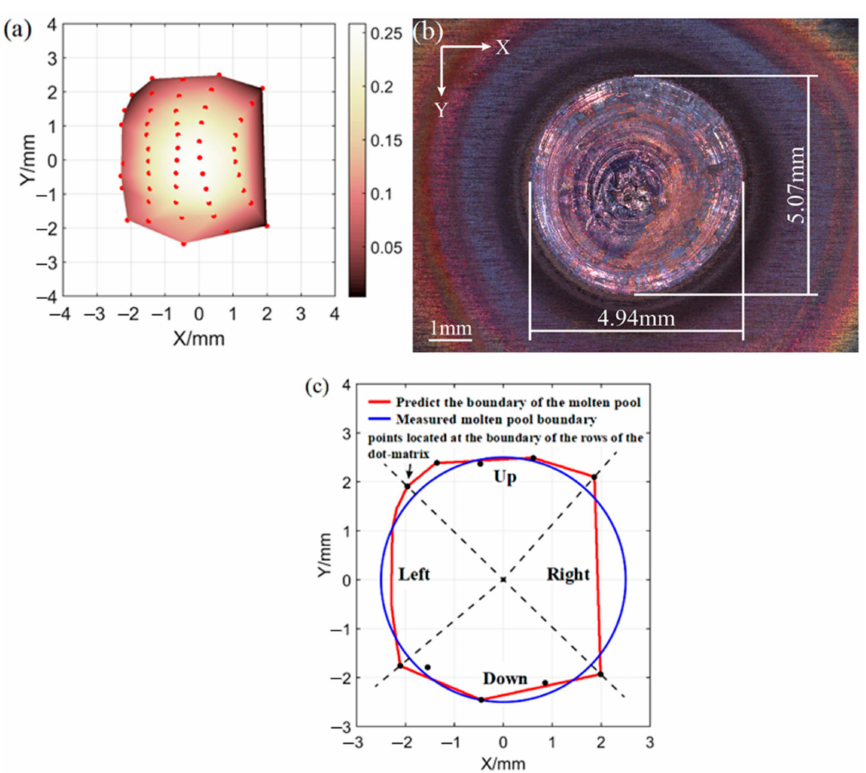
Figure 2. Comparison between the reconstructed boundary and the cross-section